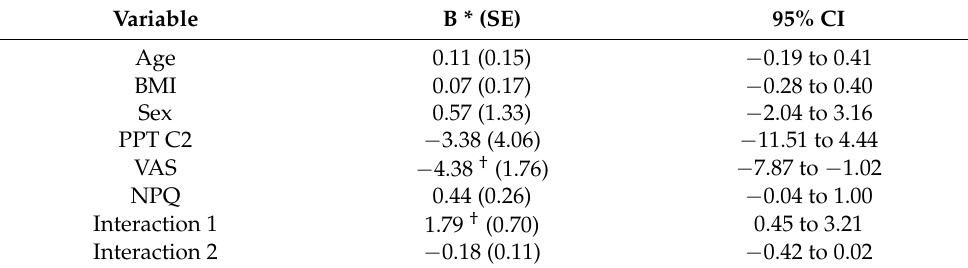
Table 2. Multiple moderation regression analysis for the prediction of the cranio-cervical angle with the pressure pain threshold measured at C2 as the focal predictor.